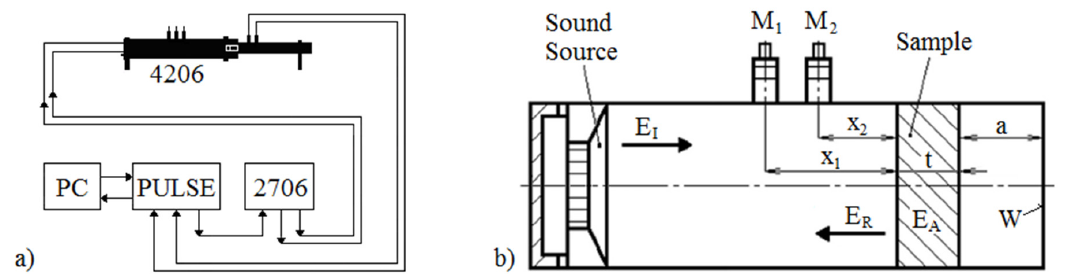
Figure 3. Schematic diagram of the apparatus for measuring the sound absorption coefficient ( a ) and